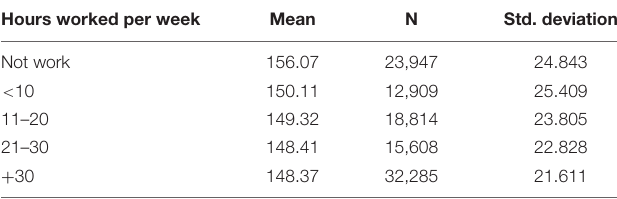
TABLE 3 | Working hours per week and SPRO